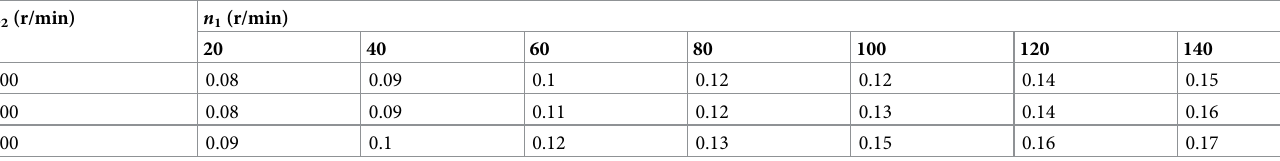
Table 9. Sand power consumption of scheme 4-6(kW � h).